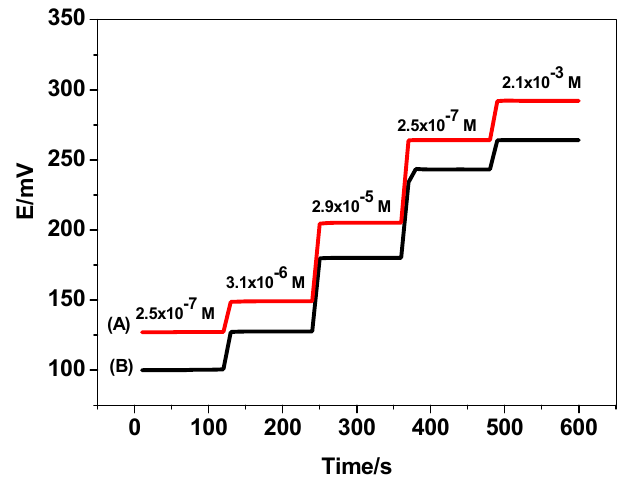
Figure 7. Time response for (A) MIP(IPU)/MWCNTs-ISEs and (B) MIP(DU)/MWCNTs-ISEs.